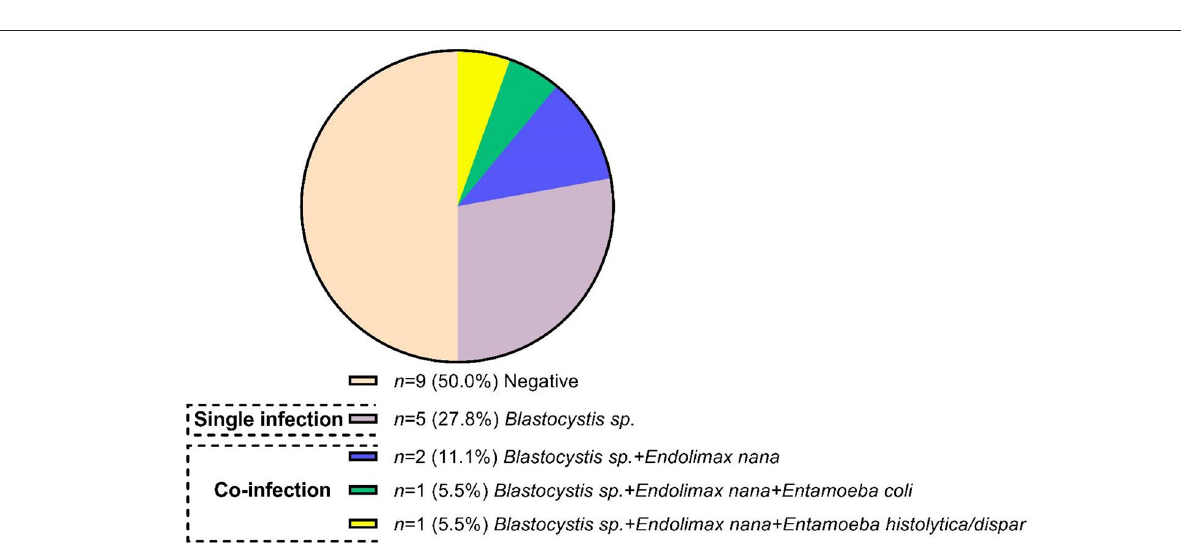
FIGURE 2 | Frequency and infection protozoa status in patients with rheumatoid